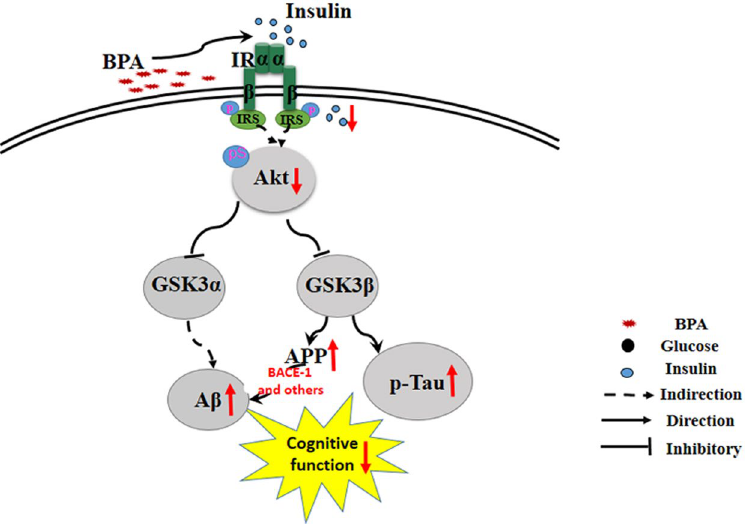
Figure 8. Hypothetical model of BPA-induced Alzheimer’s disease-like neurotoxicology. BPA disturbs the insulin signaling pathways by decreasing IR tyrosine phosphorylation and increasing IRS1